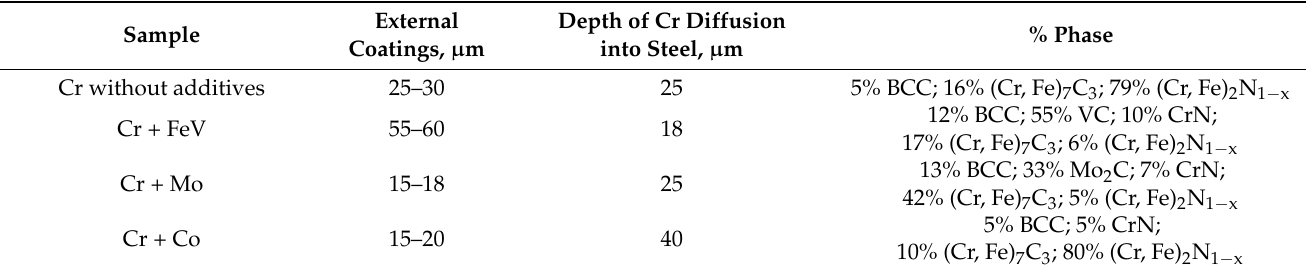
Table 2. Dimension of the coating and percentage of the phases in different